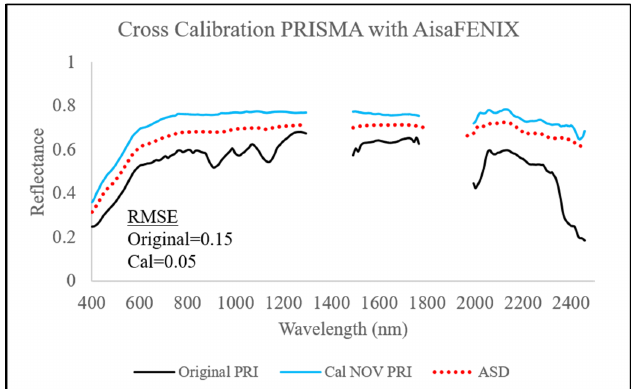
Figure 13. The AP cross-calibration result for PRISMA (PRI) with well-calibrated AisaFENIX; original reflectance (before calibration, black line), after SBAF calibration (blue line) against ASD ground truth (red dotted line).